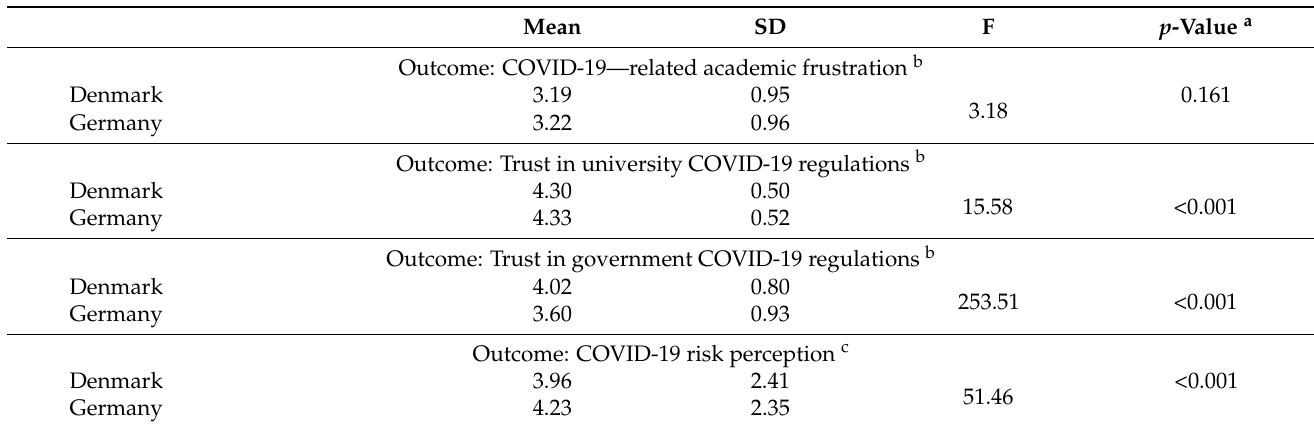
Table 2. Analysis of variance of differences in COVID-19-related academic frustration, trust in university and government regulations, and risk perception between Danish and German university students. Mean SD F p -Value a Outcome: COVID-19—related academic frustration b